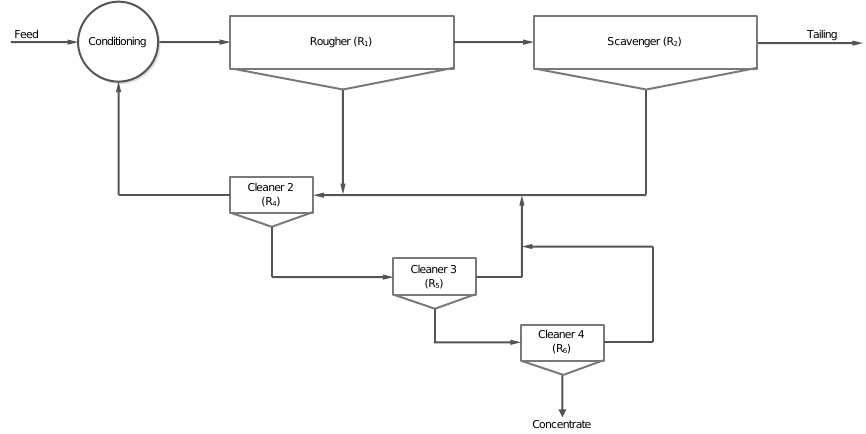
Figure 10. Elimination of cleaner-scavenger stage from the original circuit.